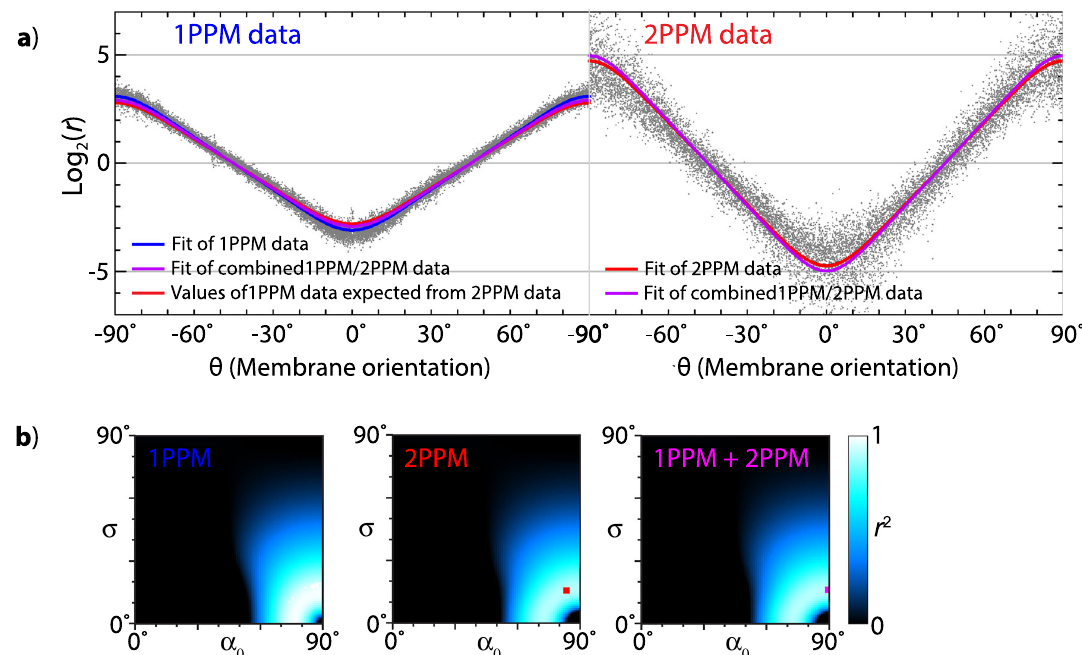
Fig. 5 Combining single- and two-photon data, illustrated on DiI-stained GUVs imaged by 1PPM and 2PPM. a Fitting of combined 1PPM and 2PPM data from multiple images. 1PPM data are shown in the left part of the plot; 2PPM data are shown in the right part of the plot. Shown in blue: best fi t of 1PPM data. Shown in red: best fi t of 2PPM data. Since two-photon data allow predicting single-photon data, a prediction of 1PPM data based on the 2PPM fi t is also shown. Shown in magenta: best fi t of the combined 1PPM and 2PPM data. b Heat maps of goodness of fi t (expressed as r 2 ) of 1PPM data (left), 2PPM data (middle), and combined 1PPM/2PPM data (right) for a range of distributions of molecular orientations (described by values of α 0 , σ